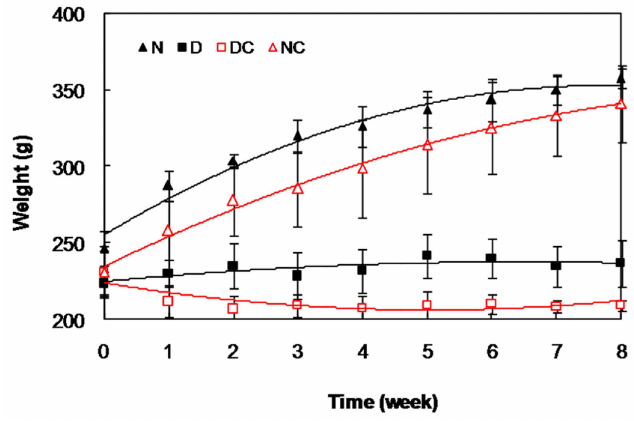
Figure 5. Changes in the body weight of all rat groups during the time course of the